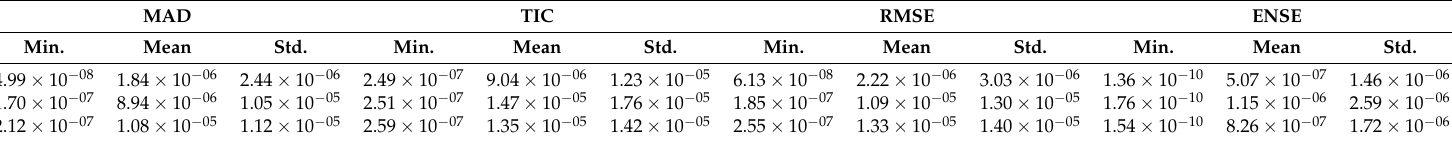
Table 12. Fitness values, MAD,TIC RMSE and ENSE for SCENARIO I of the drainage problem.